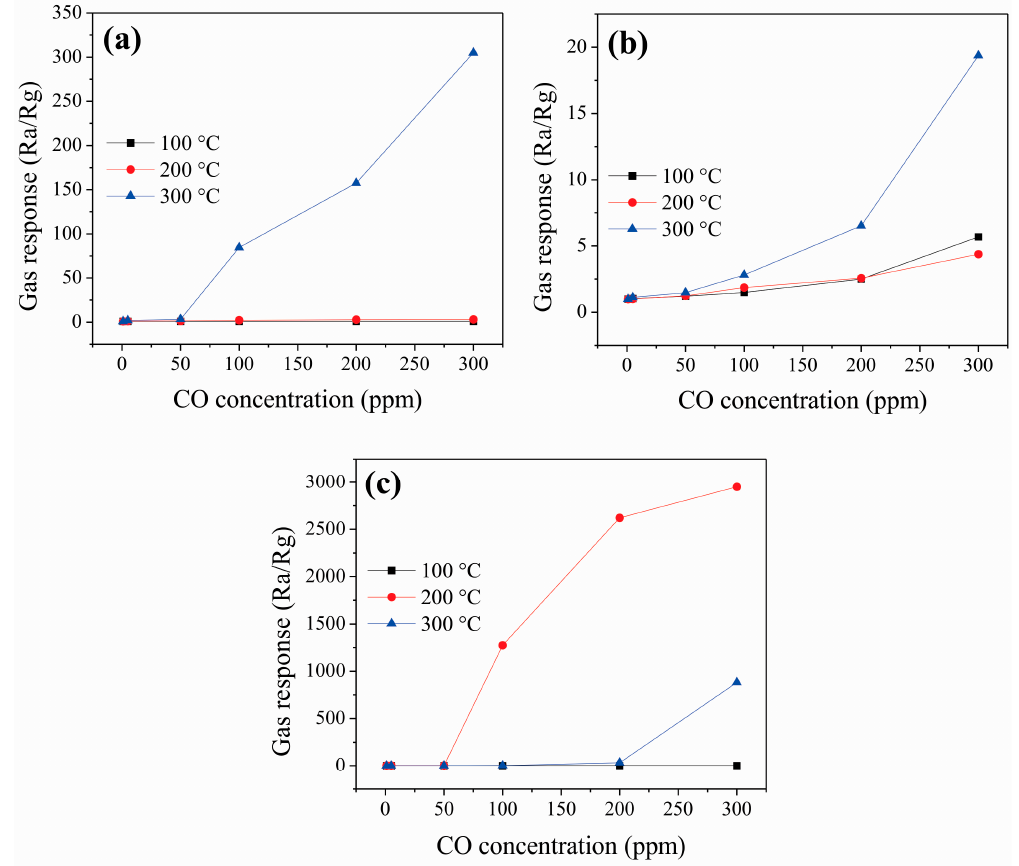
Figure 8. Gas response of ZnCo 2 O 4 sensors vs. CO concentration at different operating temperatures: ( a ) sample A; ( b ) sample B; and ( c ) sample C.